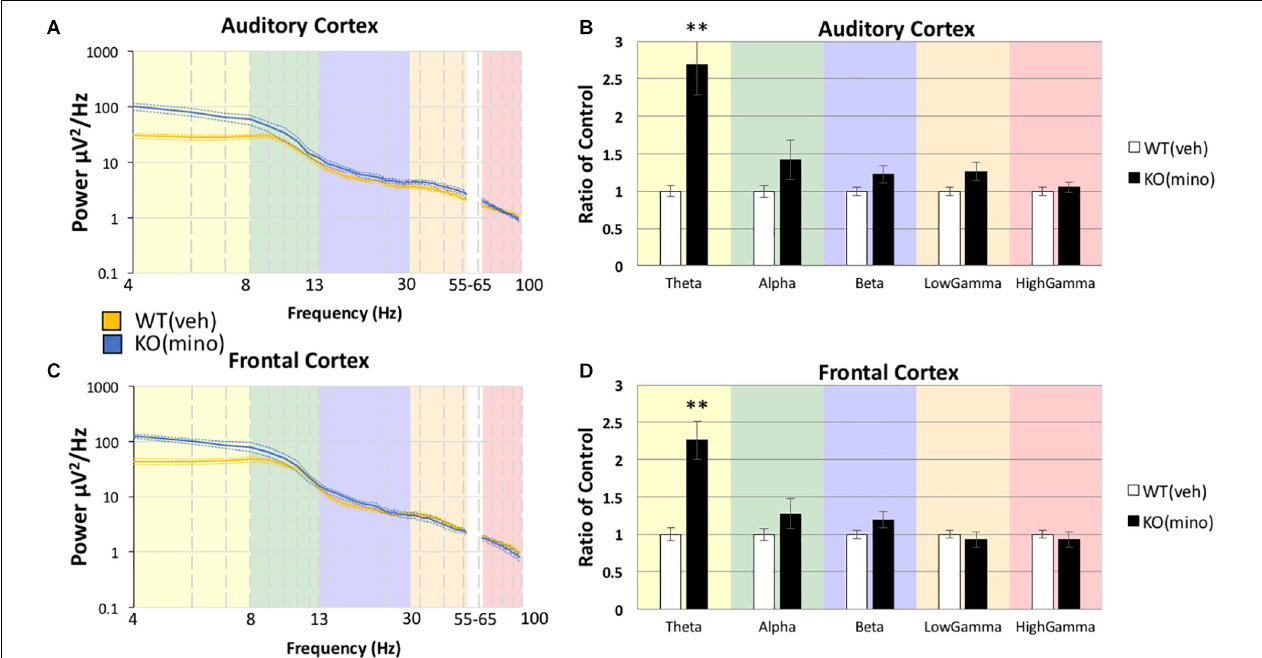
FIGURE 3 | Minocycline treatment reduces resting gamma power in Fmr1 KO mice to WT levels. After Fmr1 KO mice were treated for 10 days with minocycline, mean power density was calculated for both groups using both auditory and frontal cortex electrodes (A,C) . The most significant phenotypes in the gamma frequency range were normalized and resting gamma power was similar to WT (Veh) treatment group (B,D) . Lower frequency deficits were still present (12 minocycline KO and 12 vehicle WT; * p < 0.05, *** p < 0.01, **** p < 0.001, ***** p < 0.0001, # p < 0.00001).